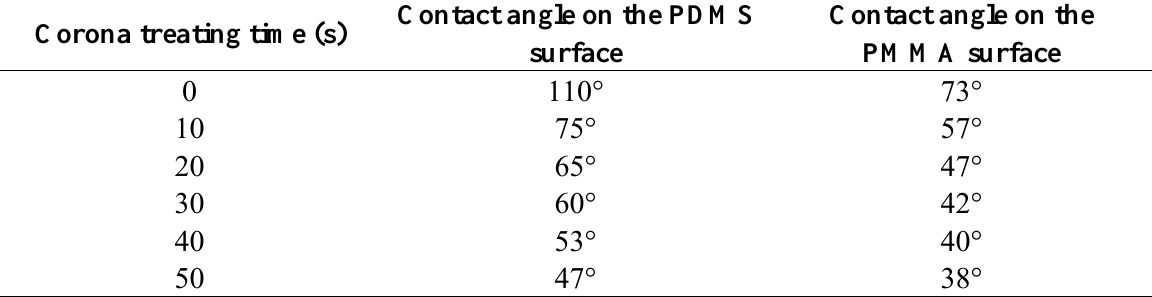
Table 2. The relation between the corona treating time and the contact angle. Corona treating time